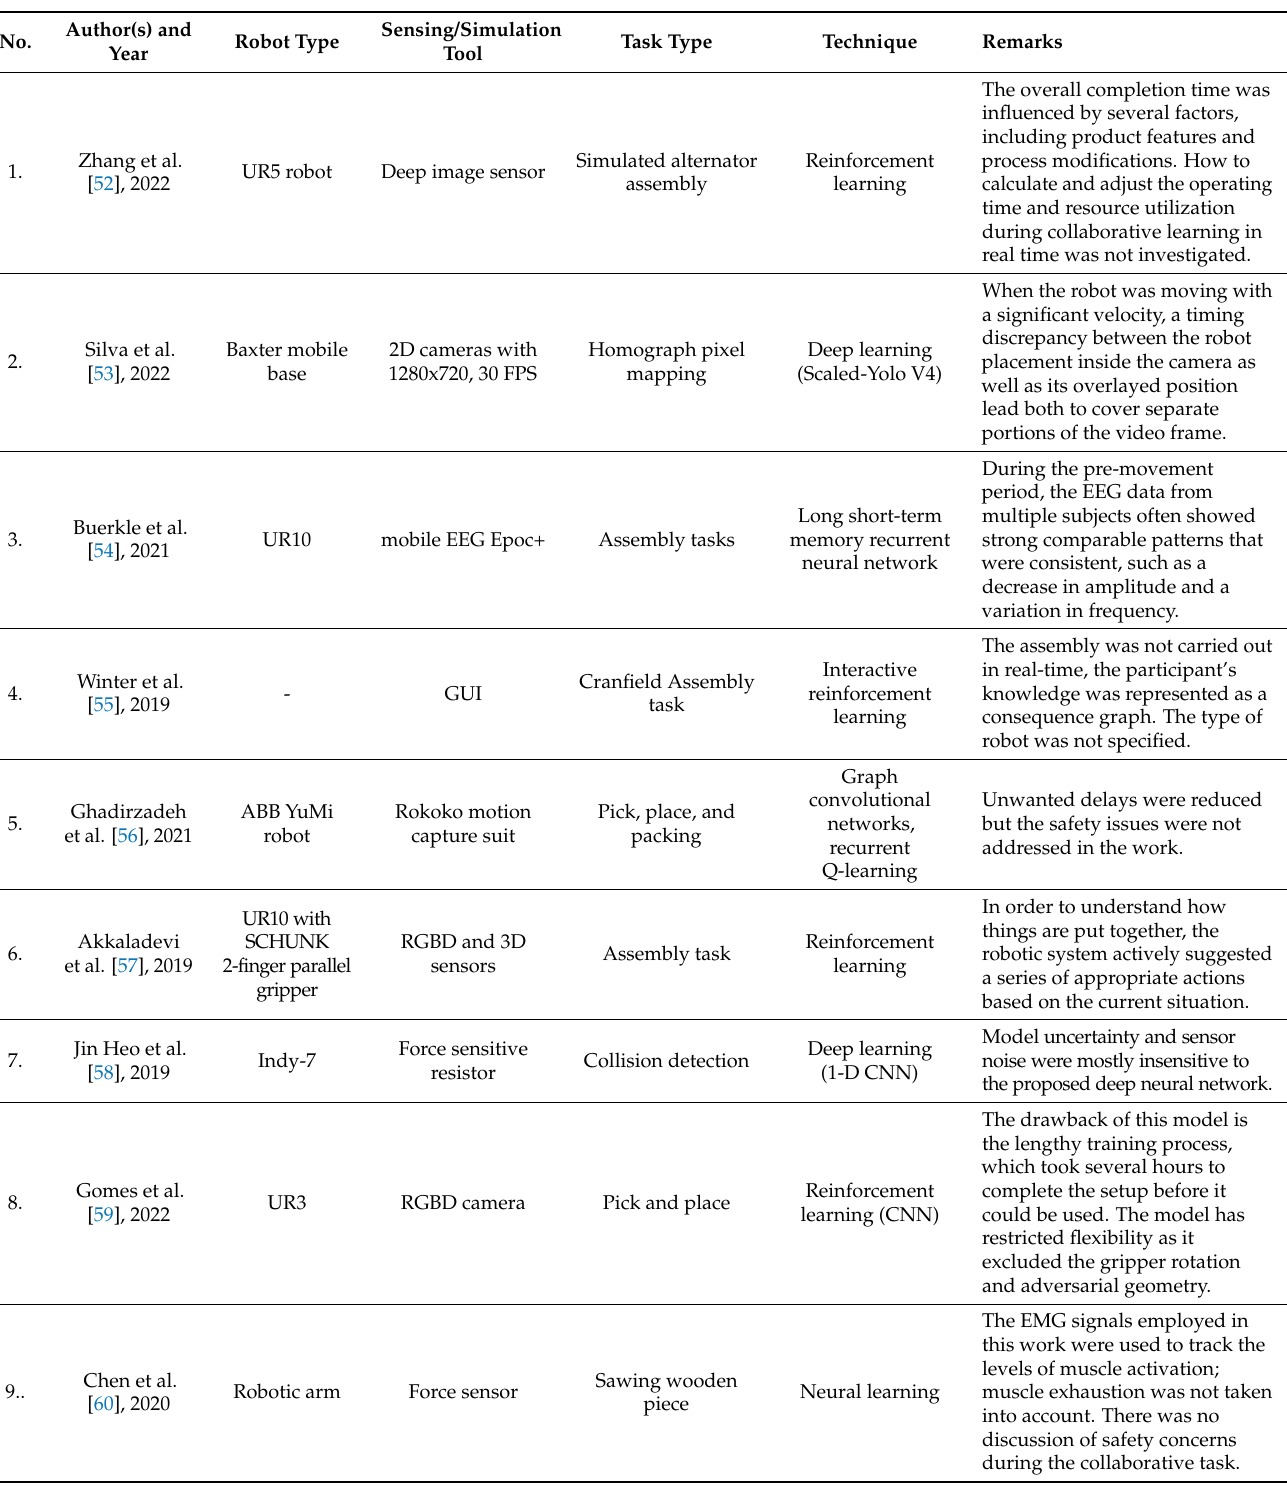
Table 3. Summary of the state-of-art research on collaborative workspace-type